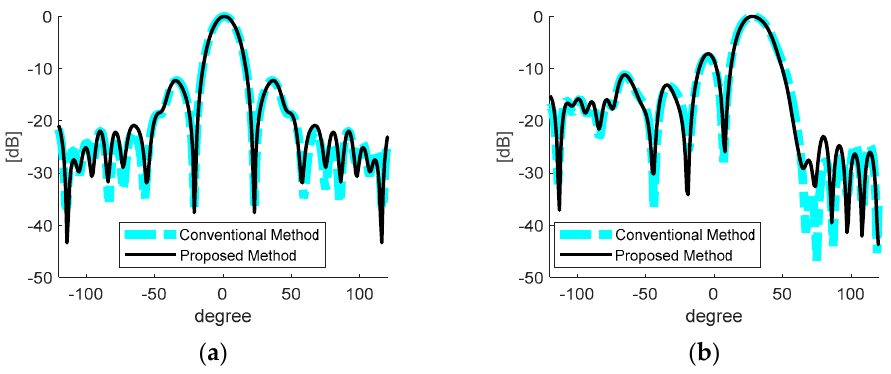
Figure 15. Comparison of beam patterns at ka = 3.5 calculated by the proposed method (solid line) and the conventional FEM (thick dashed line) when ( a ) θ = 0 ◦ and ( b ) θ = 30 ◦